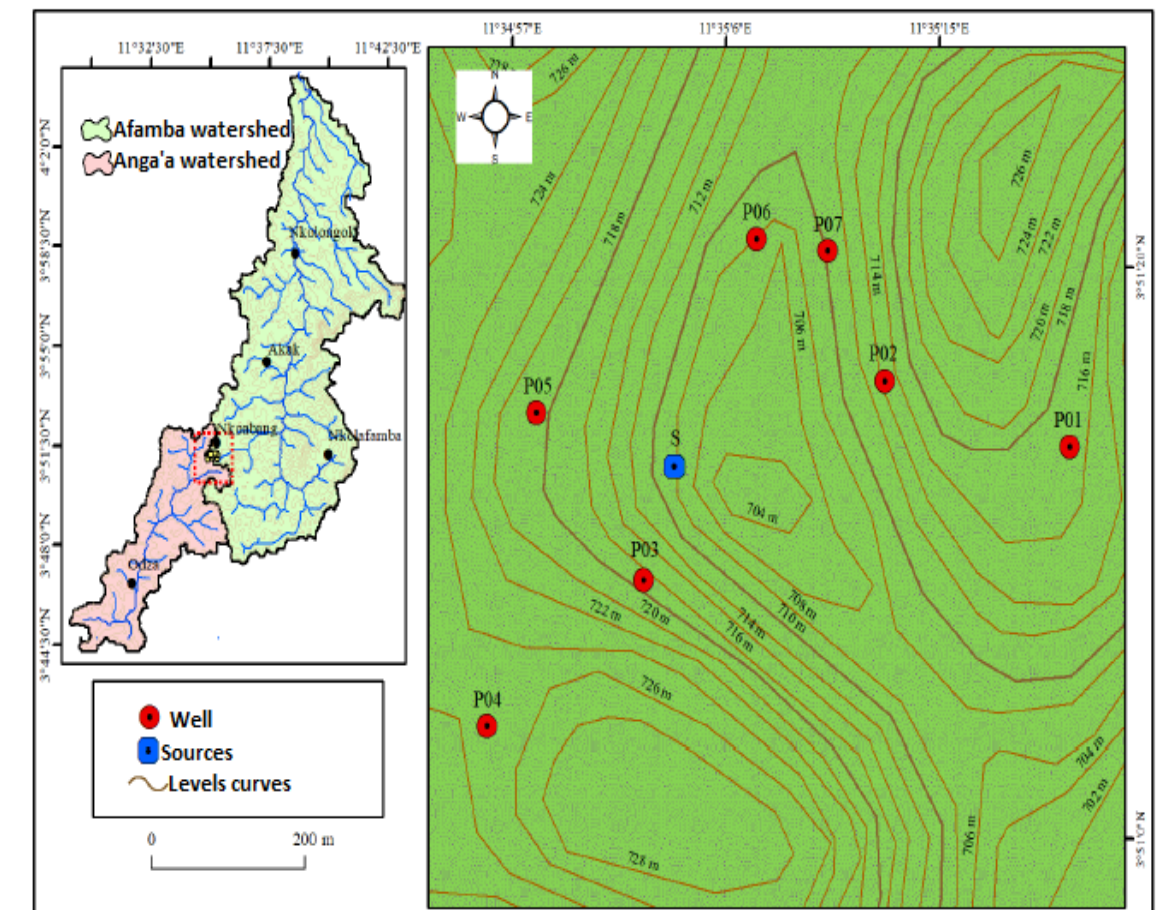
Figure 1. Measurement point